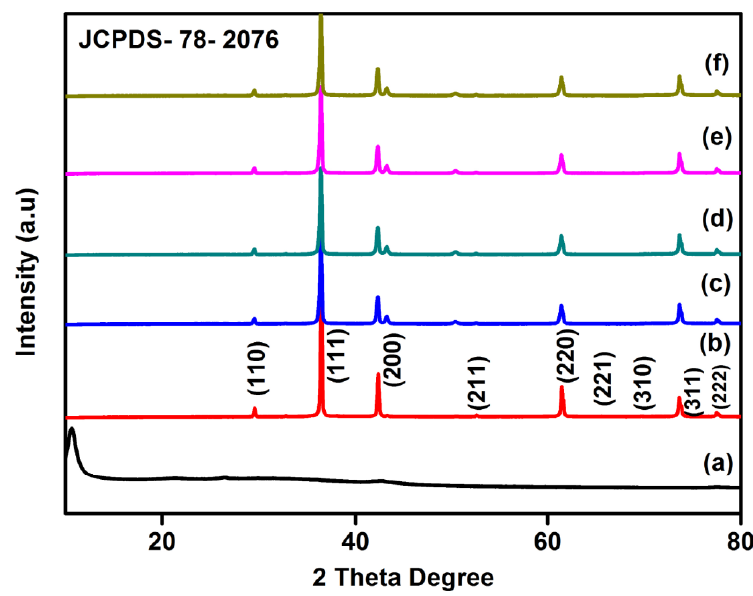
Figure 2. XRD of ( a ) GO, ( b ) Cu 2 O, and ( c – f ) GCC 1, 2, 3, and 4.